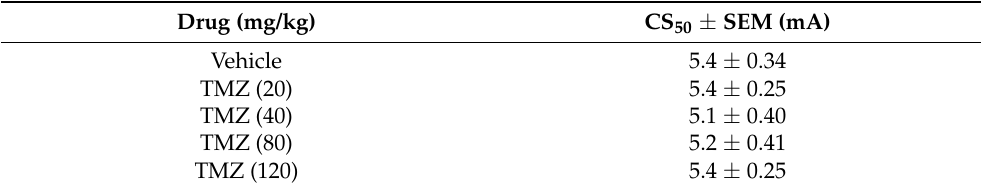
Table 2. Effect of trimetazidine on the electroconvulsive threshold in